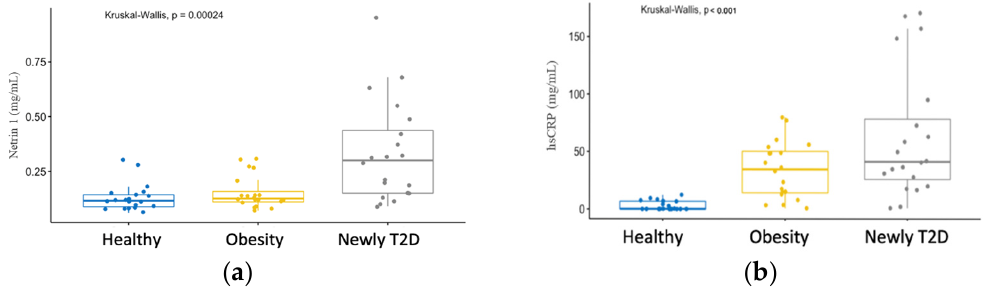
Figure 1. ( a ) Ntn1 serum concentration among study groups; and ( b ) hsCRP serum concentration